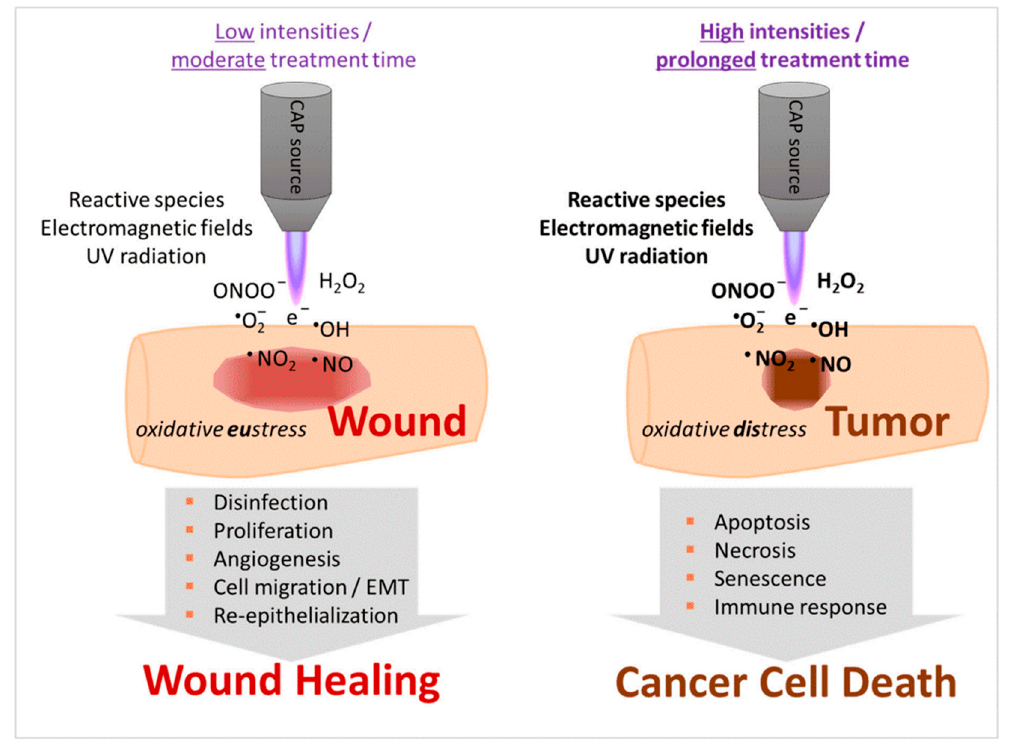
Figure 3. Comparison between CAP for wound and cancer treatment ( left ). Short or moderate treatment with a low intensity triggers biological processes essential to tissue regeneration, such as disinfection, proliferation, angiogenesis and epithelial-mesenchymal transition (EMT) ( right ). Prolonged treatment with a high intensity, in contrast, shifts the oxidative stress from eustress to distress, which is more suitable for cancer therapy. Reprinted from [15] under the terms of the Creative Commons Attribution License.